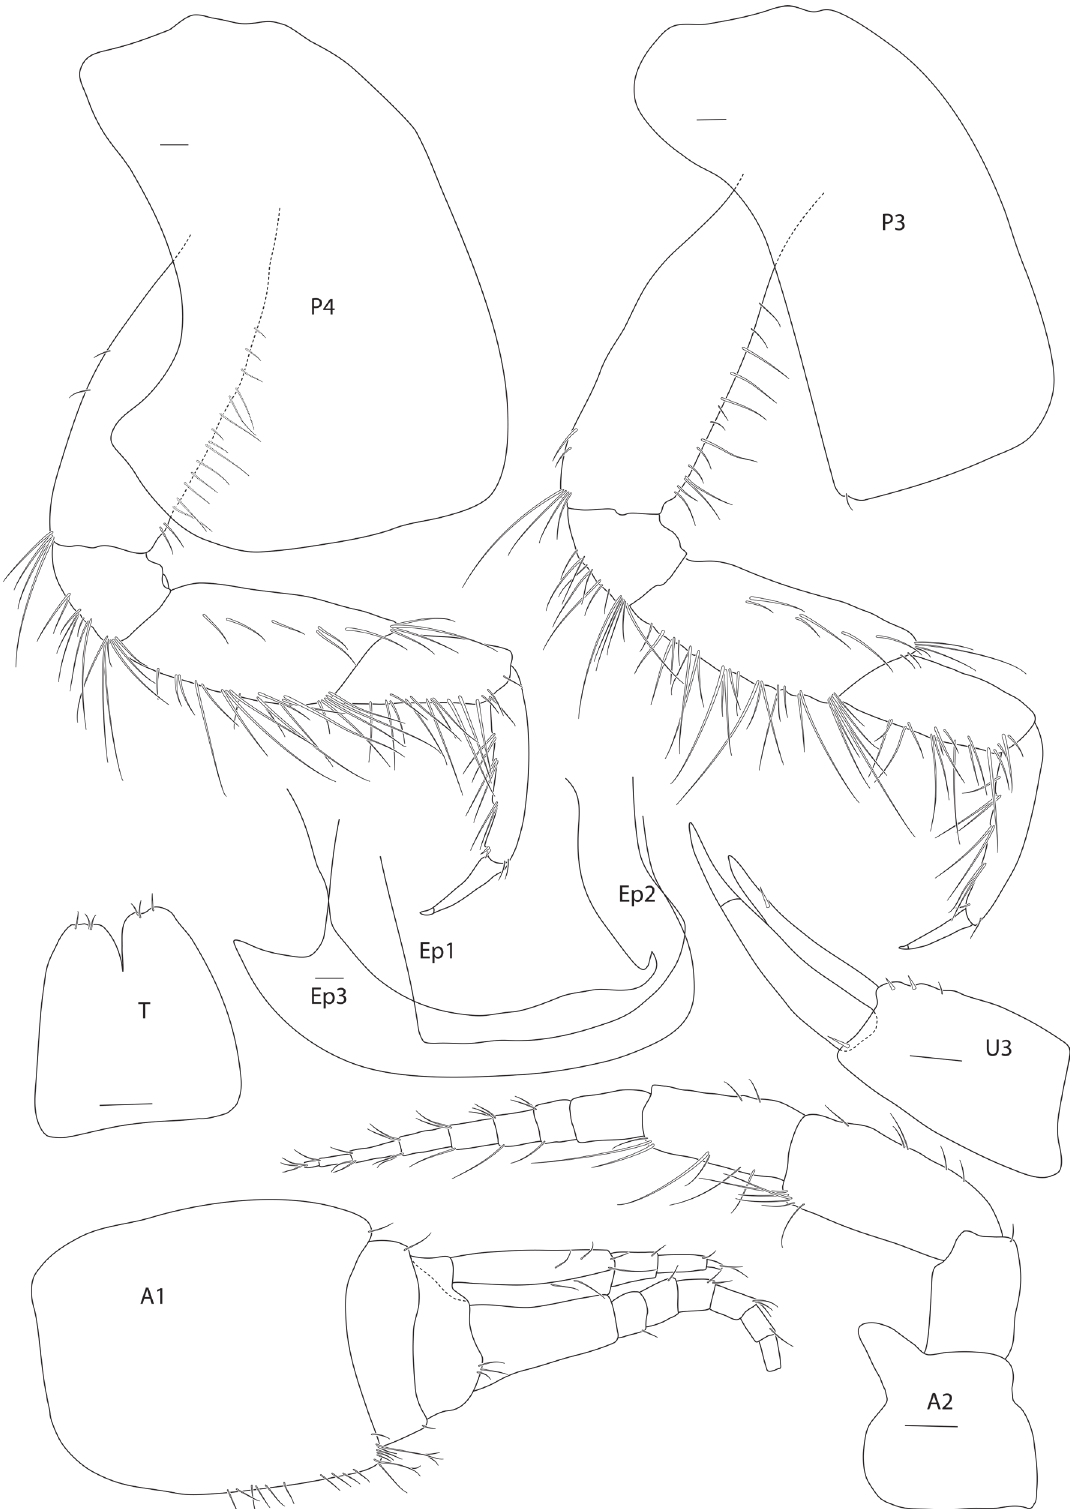
Fig. 9. Onisimus turgidus (Sars, 1879), ♀, 10 mm, Ullsfjorden (100 m depth) (TSZCr8573). Antennae 1–2, pereopods 3–4, epimeral plates 1–3, uropod 3, telson. Abbreviations: see Material and methods. Scale bars = 0.1